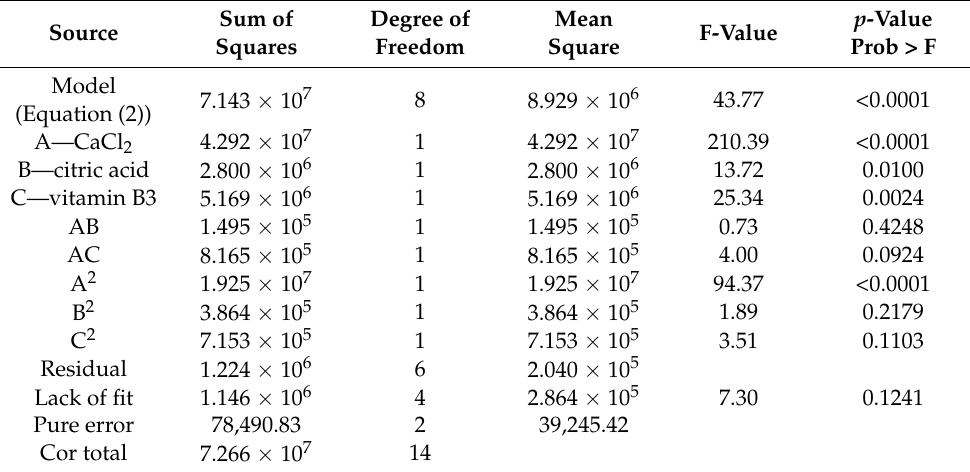
Table 3. Analysis of variance: Box–Behnken-modified quadratic response surface model of HMF formation (Equation